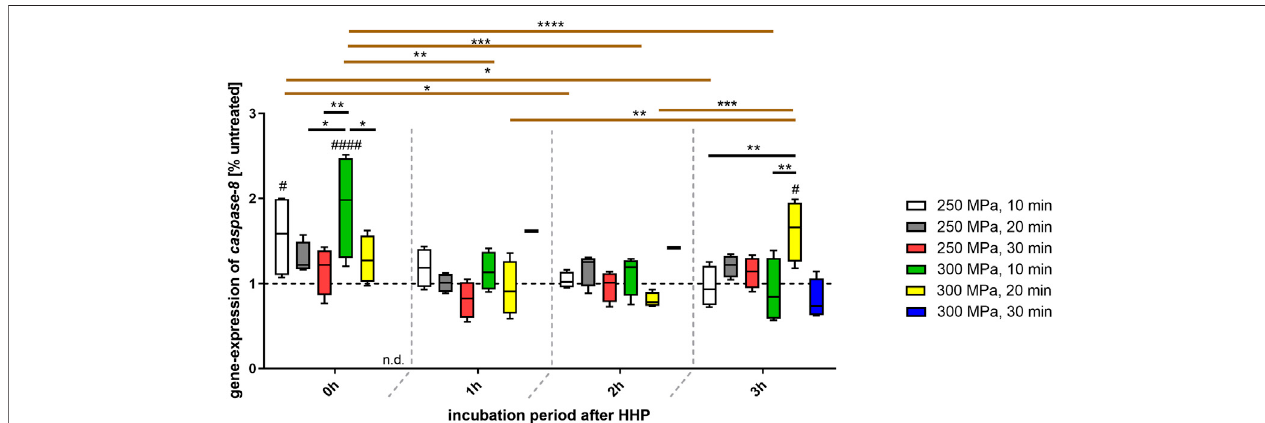
FIGURE5| Geneexpressionof caspase-8 inhumantrabecularbonefollowingHHP-treatment.Dataaredepictedasboxplotswithmeansandinterquartileranges from 25 to 75%. Gene expression is shown as percentage of untreated tissue (broken line at 1). Statistical Analysis was performed using two-way-ANOVA ( n (cid:2) 4) with Bonferroni ’ s multiple comparison test as post hoc test. Signi fi cantly different from untreated control: # p ≤ 0.05; #### p ≤ 0.0001. Signi fi cant differences between HHP- treatments: * p ≤ 0.05; ** p ≤ 0.01;*** p ≤ 0.001;**** p ≤ 0.0001.Blacklines showsigni fi cantdifferences between thedifferenttreatmentswithin thesame incubation period, brown lines show signi fi cant differences between the same treatment at different points of incubation time. Abbreviations: n.d. (cid:2) not detectable.